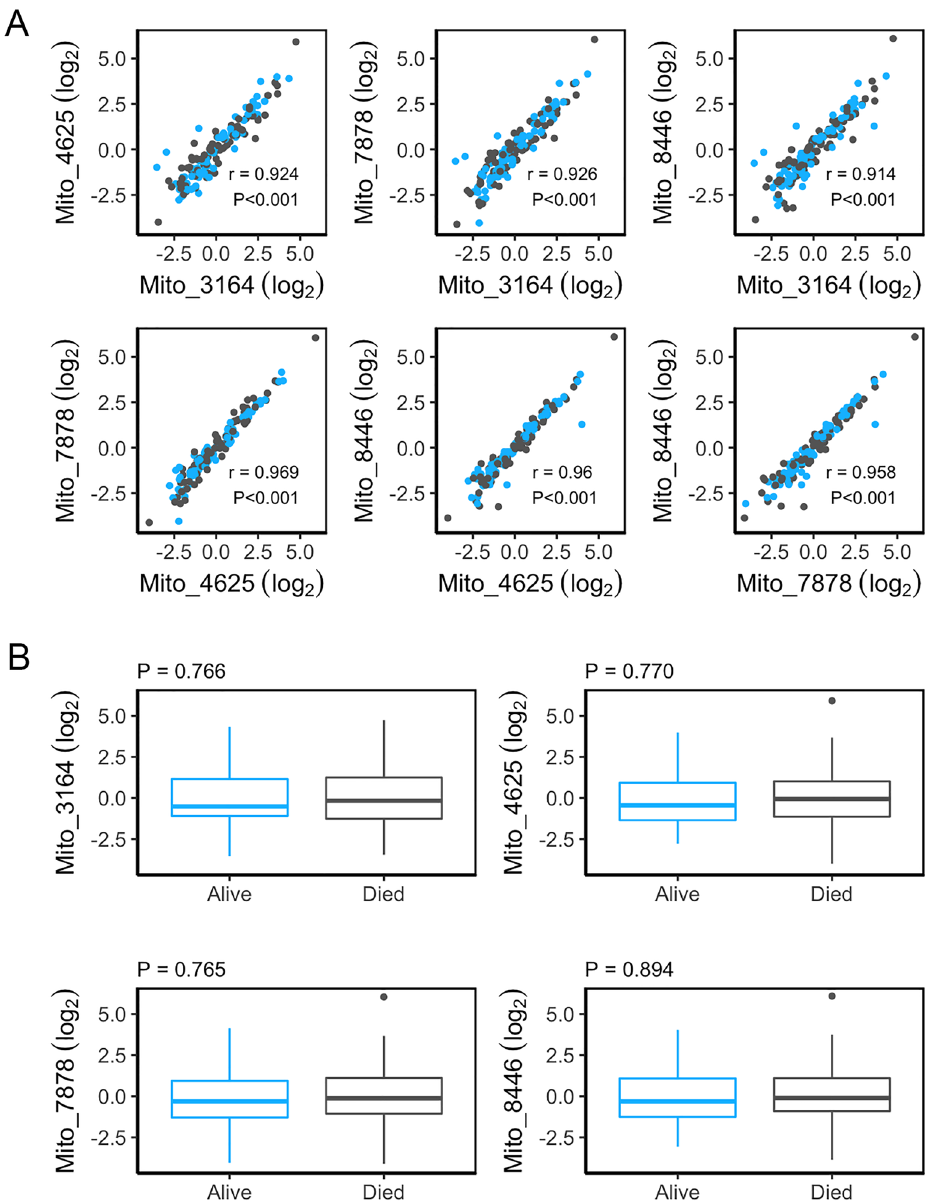
Figure 2. Association of mtDNA levels and mortality. ( A ) Plasma EVs were isolated from 76 individuals deceased within 5 years of sample donation along with 76 surviving individuals. DNA was isolated and EV mtDNA levels (log 2 transformed) were measured using mtDNA specific primers from four different regions of the mitochondrial genome using qPCR. Pearson correlation r and P values are indicated for each primer pair. ( B ) Linear regression was used to determine the relationships between mtDNA levels (log 2 transformed) and mortality status accounting for sex, race, and poverty status. There were no significant